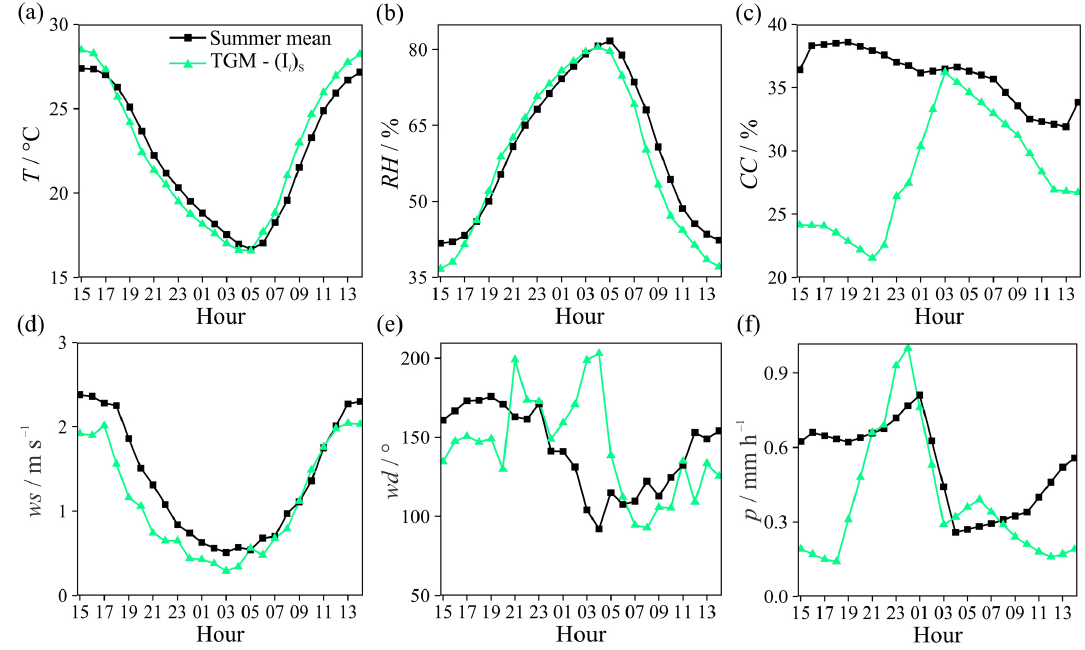
Figure 15. Diurnal composites, based on hourly means, of (a) air temperature, (b) relative humidity, (c) cloud cover, (d) wind speed, (e) wind direction, and (f) precipitation, for summer mean, and persistent temperature inversion events detected in summer by the TGM. No persistent temperature inversion events were detected by the RBM this